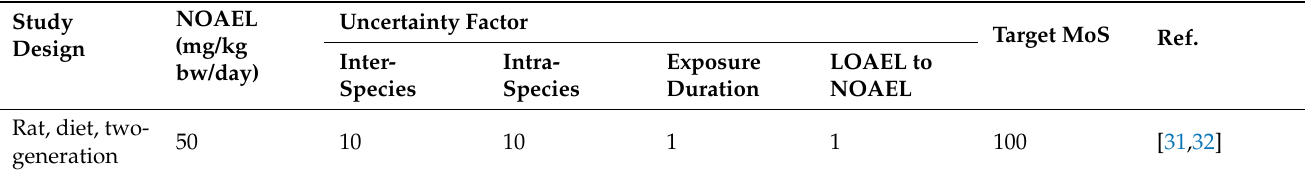
Table 4. Summary of the toxicological evaluation for BIT reported by